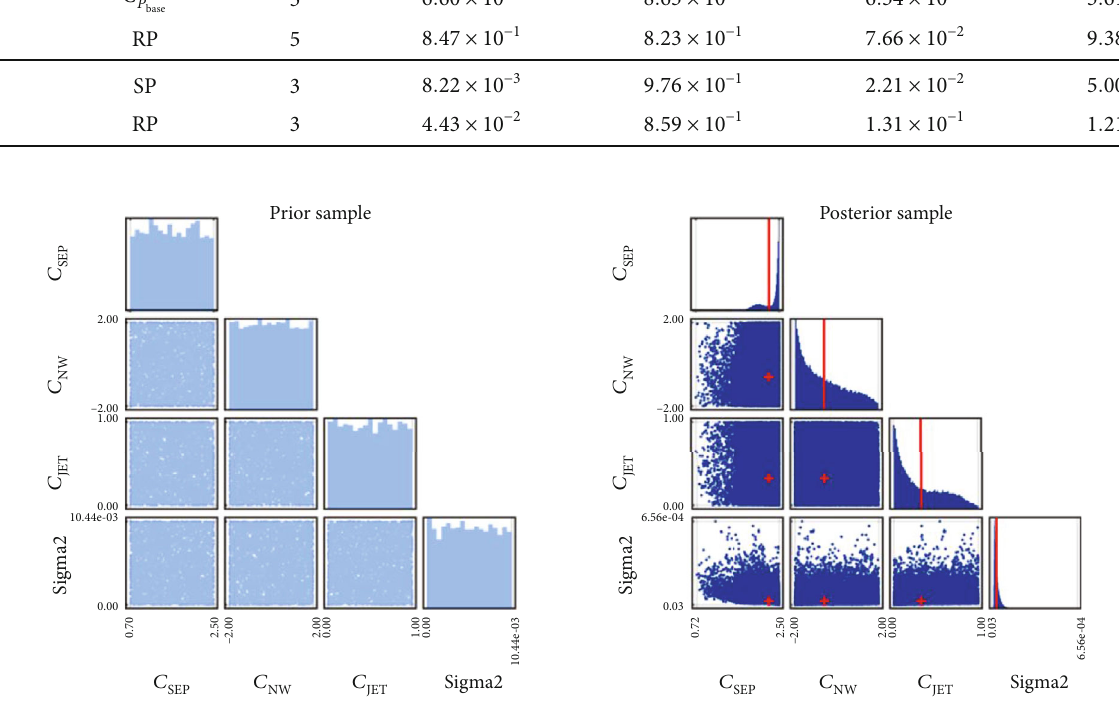
Figure 14: Prior and posterior distributions of C